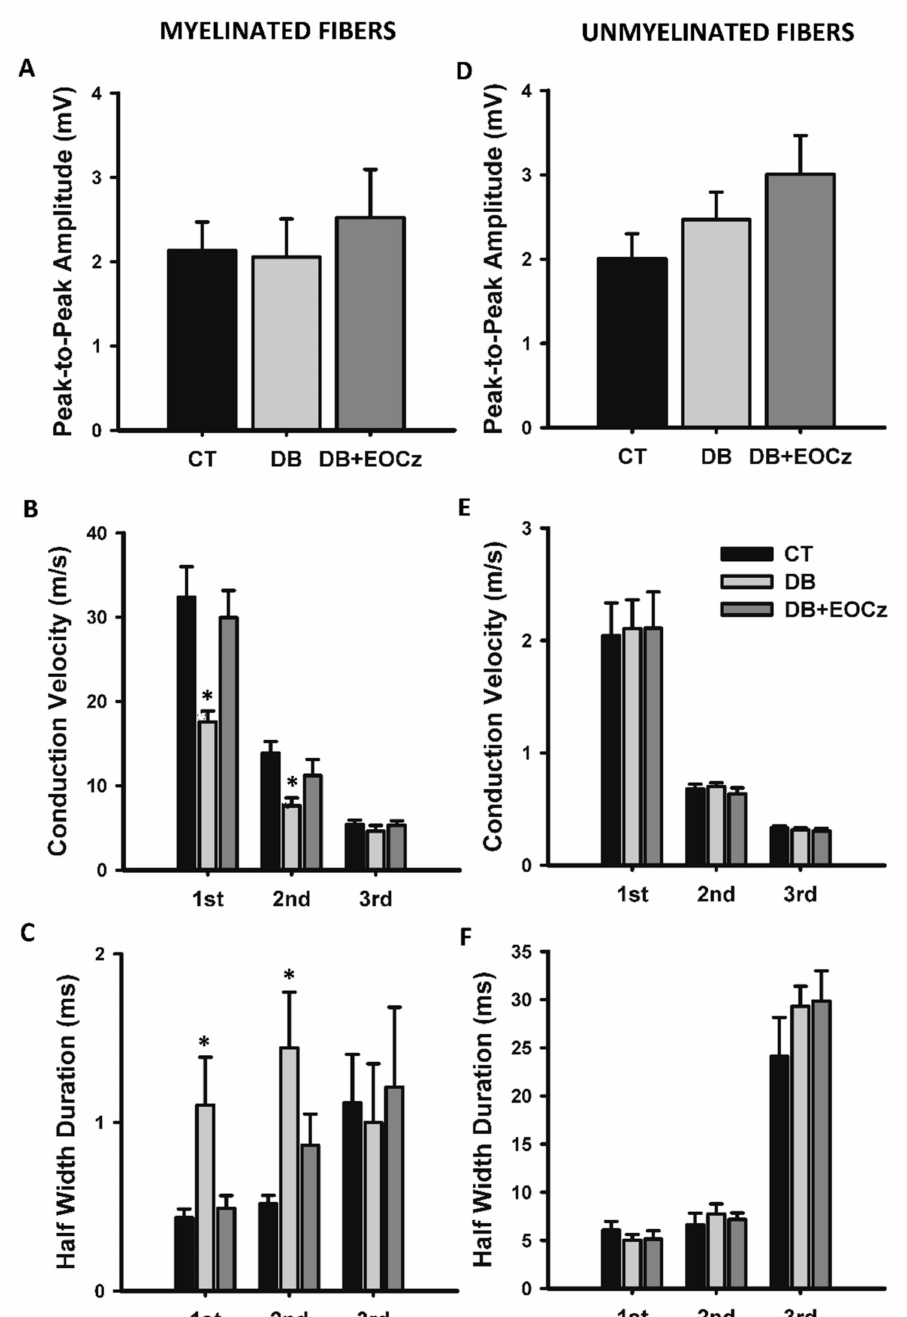
Figure 4. Preventive effect of EOCz treatment on the alterations produced by DM on the conductibility of myelinated and unmyelinated fibers of the vagus nerve. Panels ( A – C ) represent peak-to-peak amplitude, conduction velocity and half width duration, respectively, of CAP myelinated fibers, whilst panels ( D – F ) represent, respectively, the same above parameters for unmyelinated fibers. The 1st, 2nd, and 3rd indicated at the bottom of each graph refer to the components (waves) viewed on the myelinated and unmyelinated CAP. Same legend for all panels: CT, control; DB, diabetic; DB + EOCz, diabetic treated with EOCz. Data are presented as mean ± E.P.M and *, p < 0.05, when compared to control and to DB + EOCz groups (one-way ANOVA, followed by Dunn’s